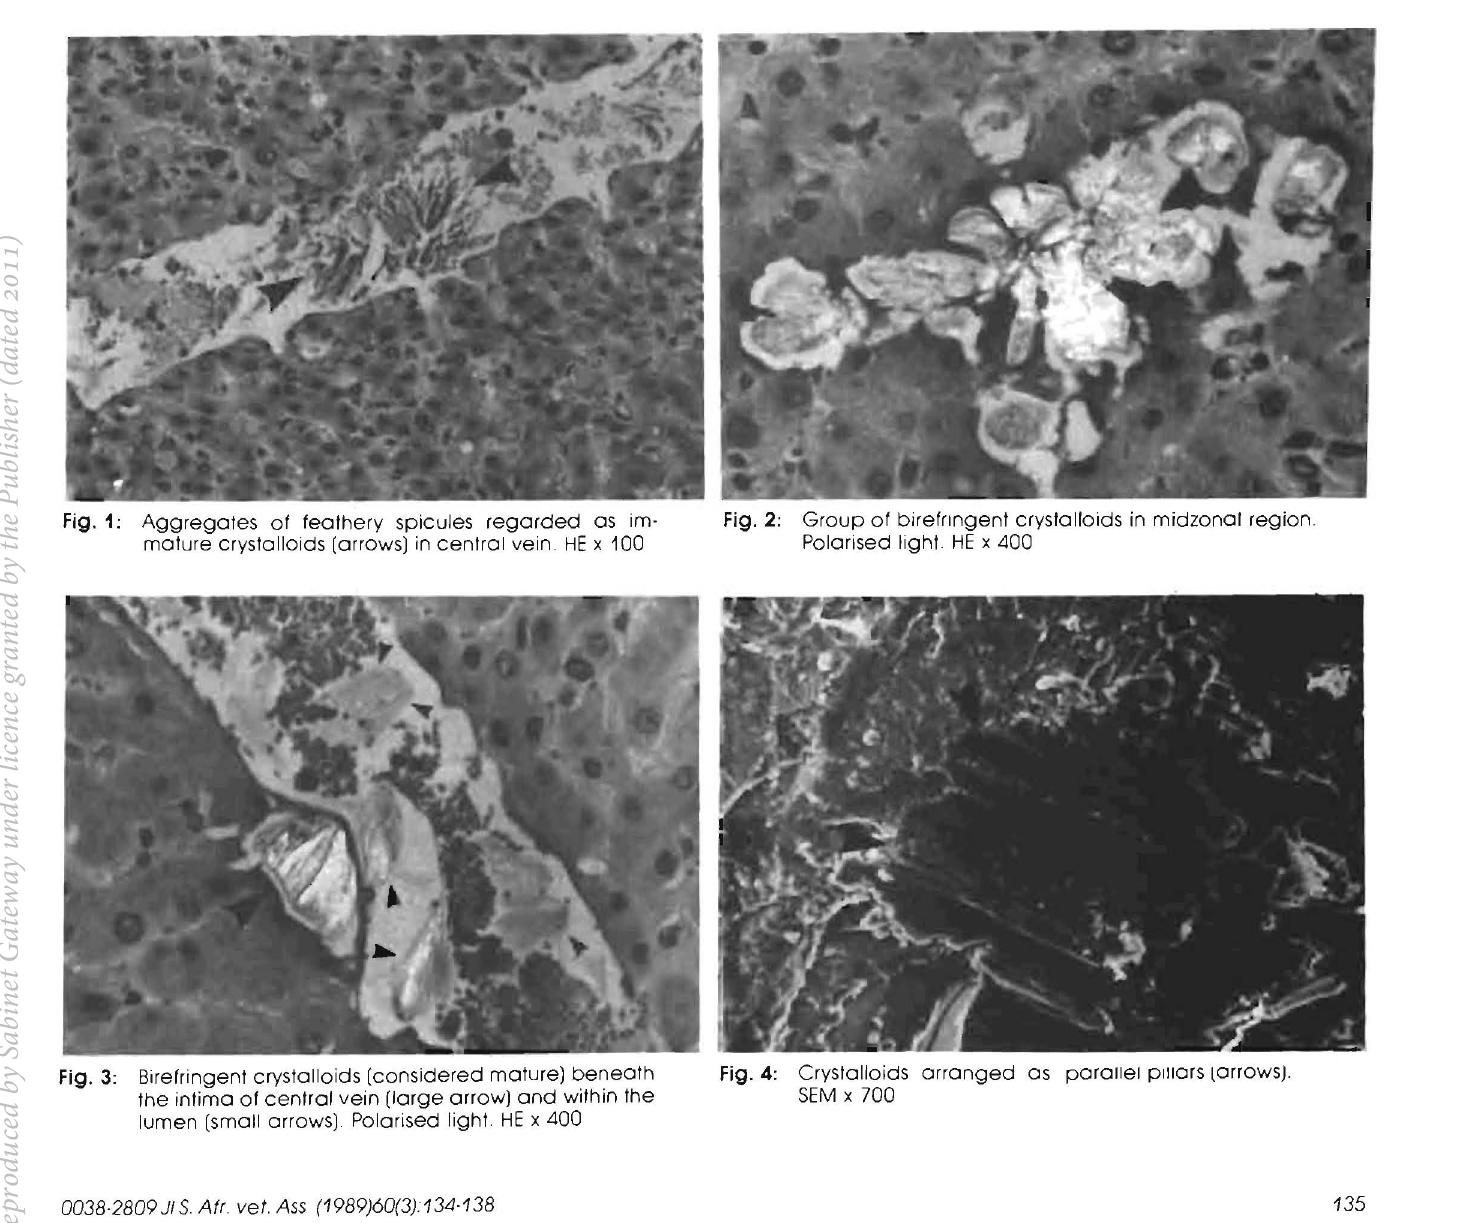
Fig. 3: Birefringent crystalloids (considered matureJ beneath the intima of central vein (large arrow) and within the lumen (small arrows). Polarised light HE x 400